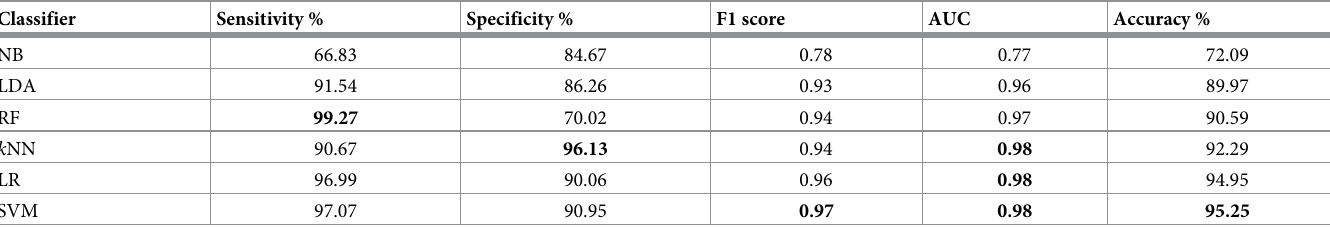
Table 1. Overall performance for different ML